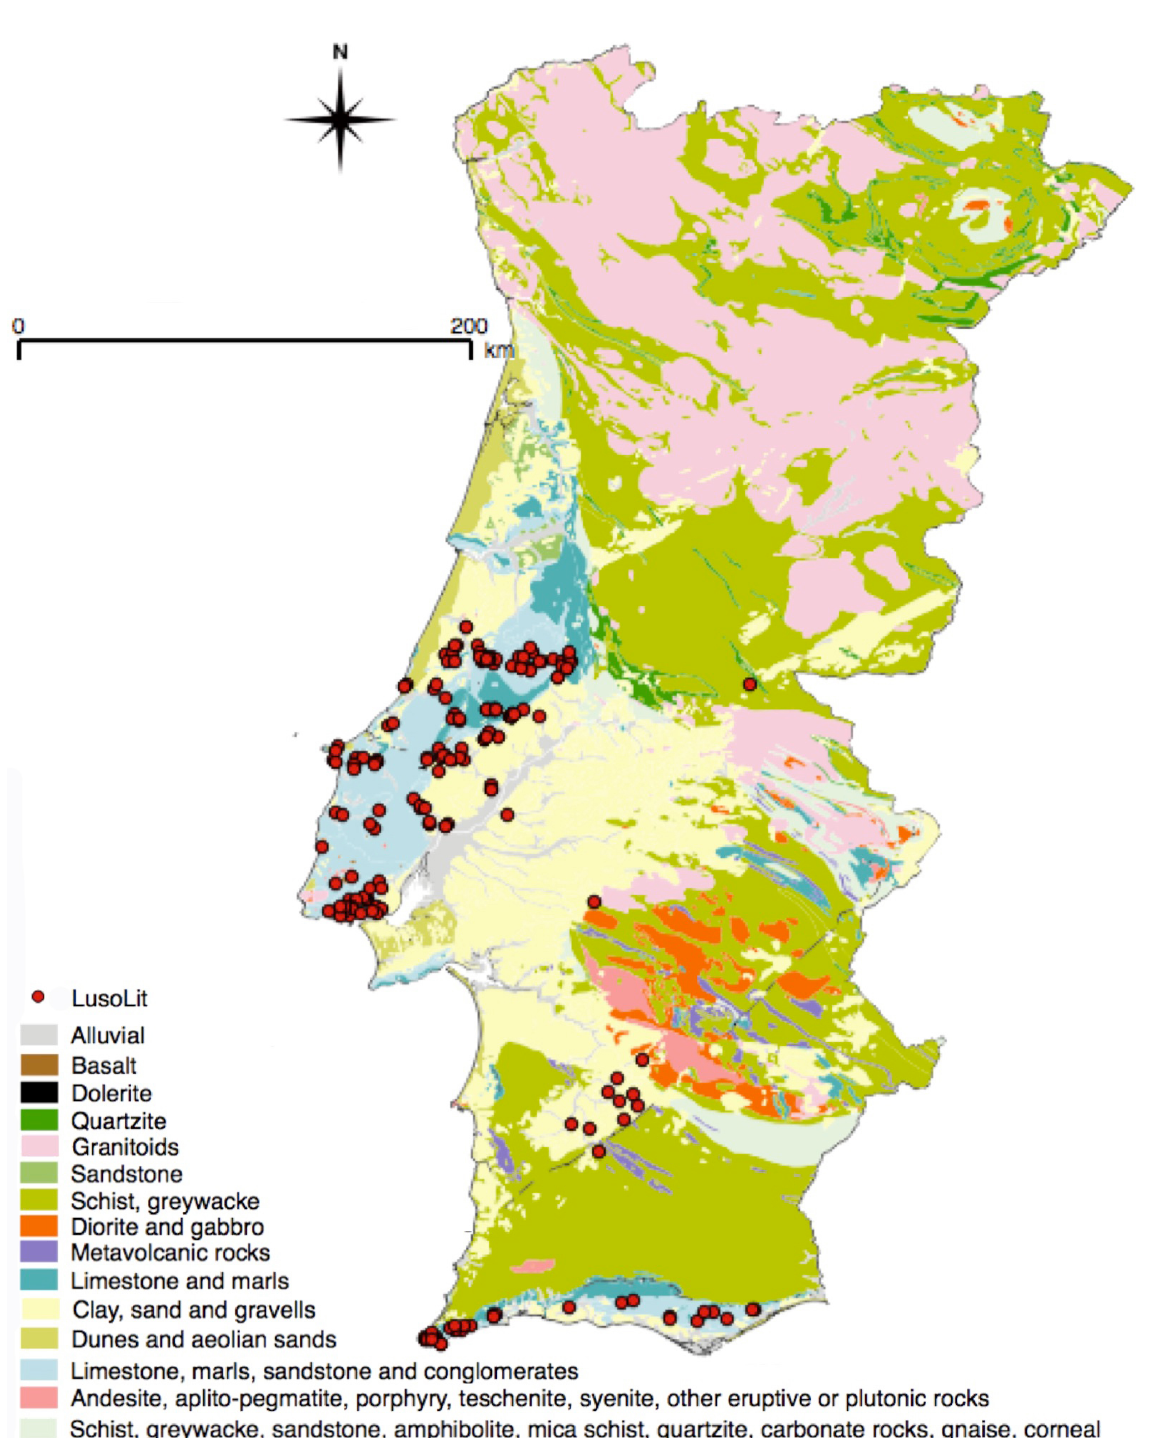
Figure 1. Simplified lithological map of the Portuguese territory with the chert sources present in the LusoLit database, build with the 1:1,000,000 shapefile of the lithological map produced by Instituto do Ambiente (Soares da Silva